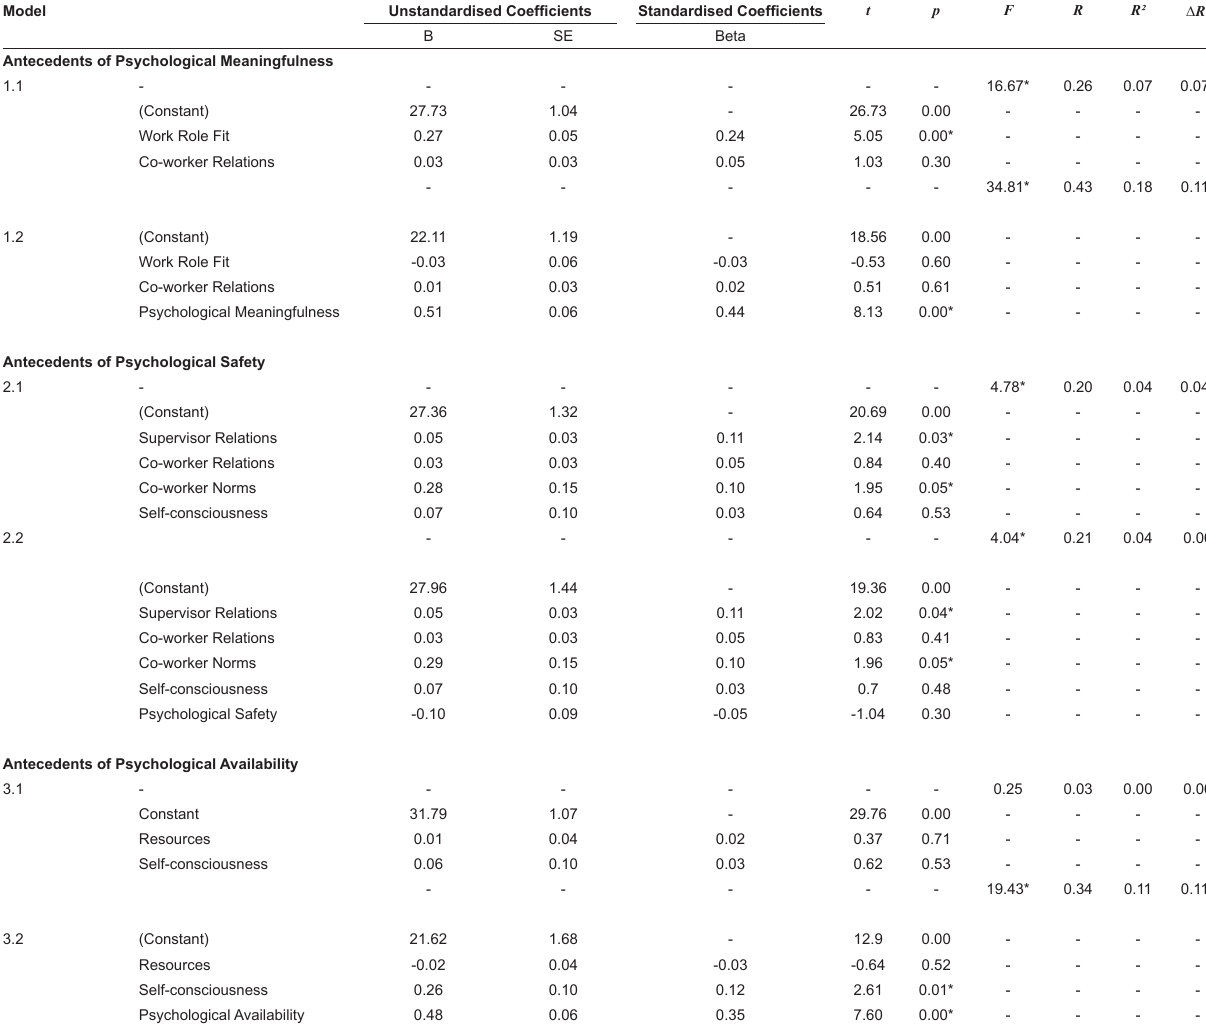
TABLE 5 Regression analyses of psychological conditions and antecedent factors as independent variables on employee engagement as dependent variable (study